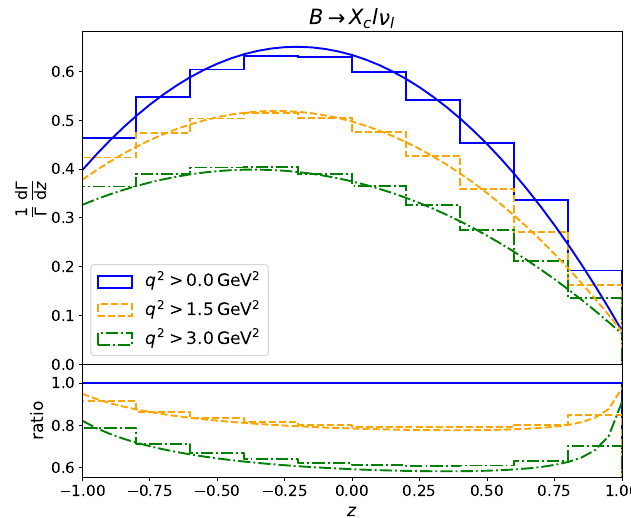
Figure 4: The differential decay rate for three values of q 2 = 0 GeV 2 ). The solid and dashed curves are the same HQE predic- decay rate ( q 2 cut tions shown in Fig. 2, while the histograms are the simulation results from Sherpa . The lower panel shows the ratios of the dashed curves to the solid